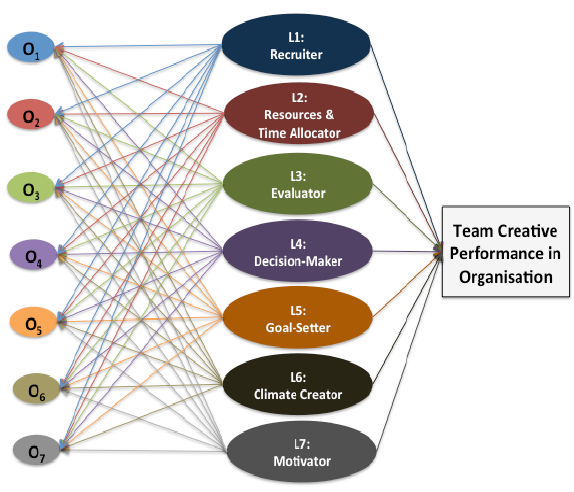
Fig. 4. Observed and latent leadership variables related